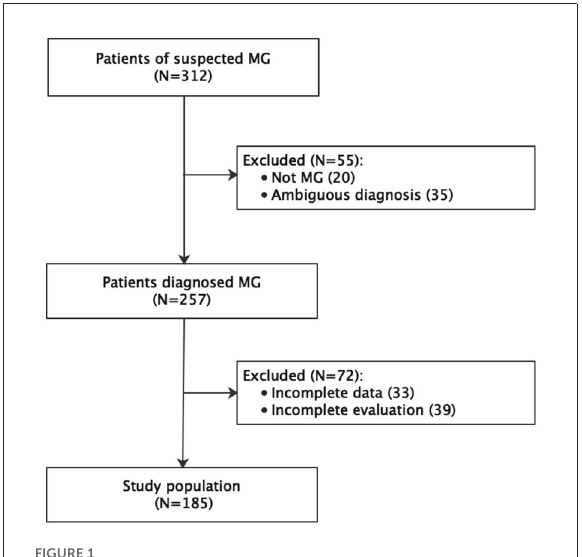
FIGURE1 Recruitment flowchart. MG, myasthenia